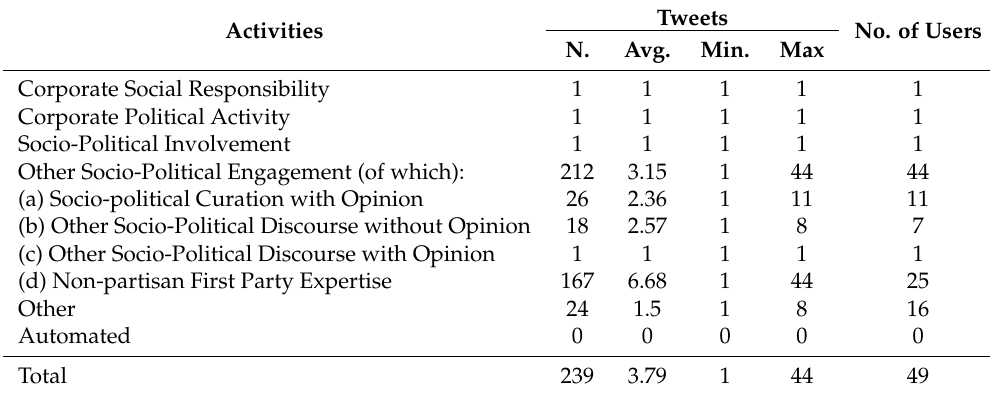
Table 12. Socio-Political Engagement of Non-Media